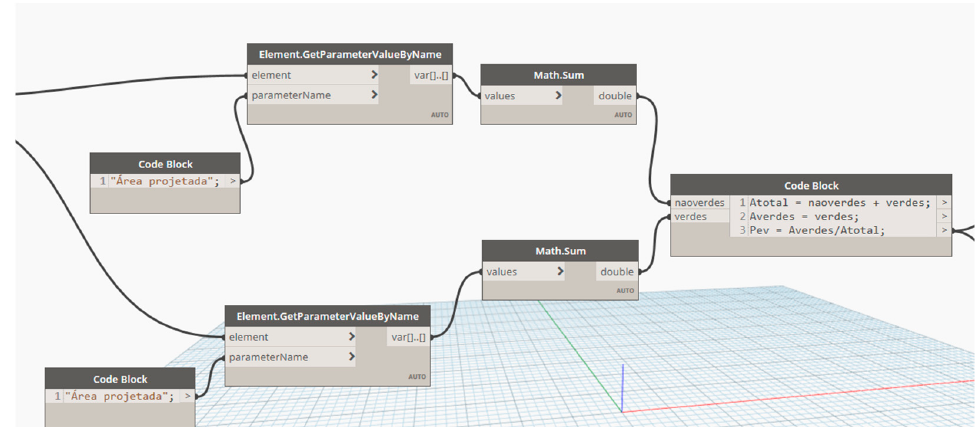
Figure 6. Areas characterized according to the parameter “ IsGreenArea ”.